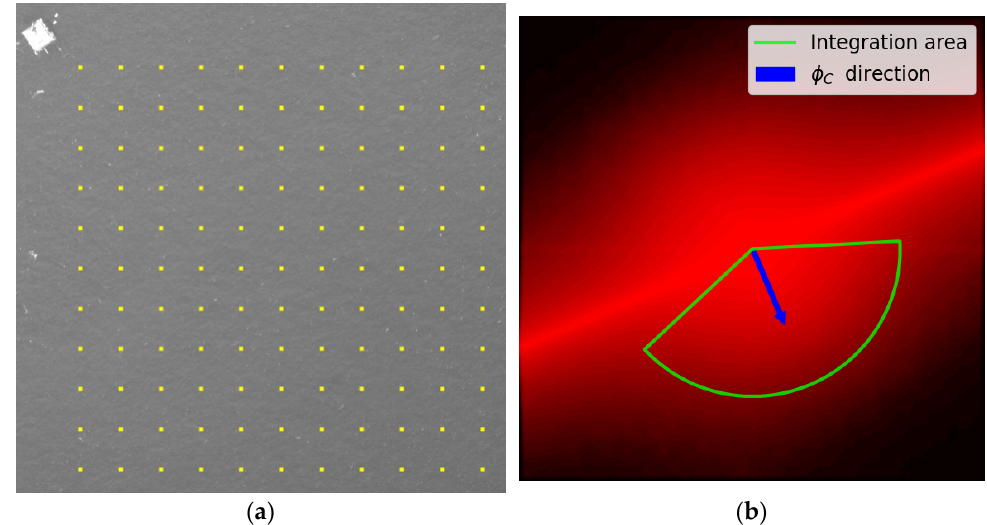
Figure 10. ( a ) The points near the platform that are upper right corners of the selected fragments. ( b ) The region of the retrieved spectrum integration. Red background represents a smoothed retrieved elevation spectrum and blue indicates the sun azimuth direction.